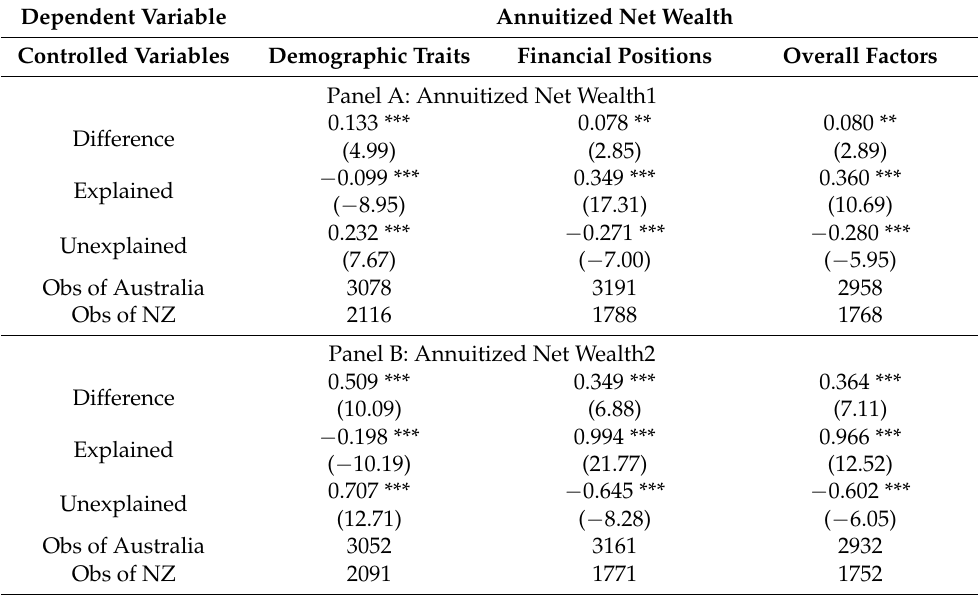
Table 13. Recentred influence function